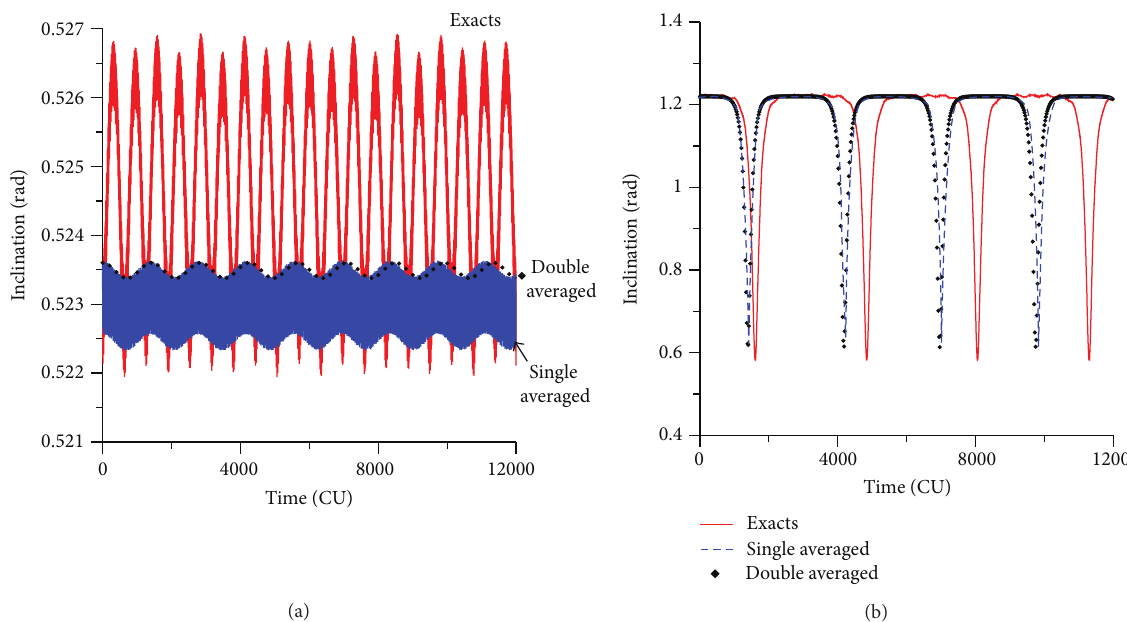
Figure 3: Evolution of the inclination for values of the initial inclination of 30 ∘ and 70 ∘ . Initial conditions are a = 0.341 canonical units, e = 0.01, 𝜔 = 0, and Ω = 0.